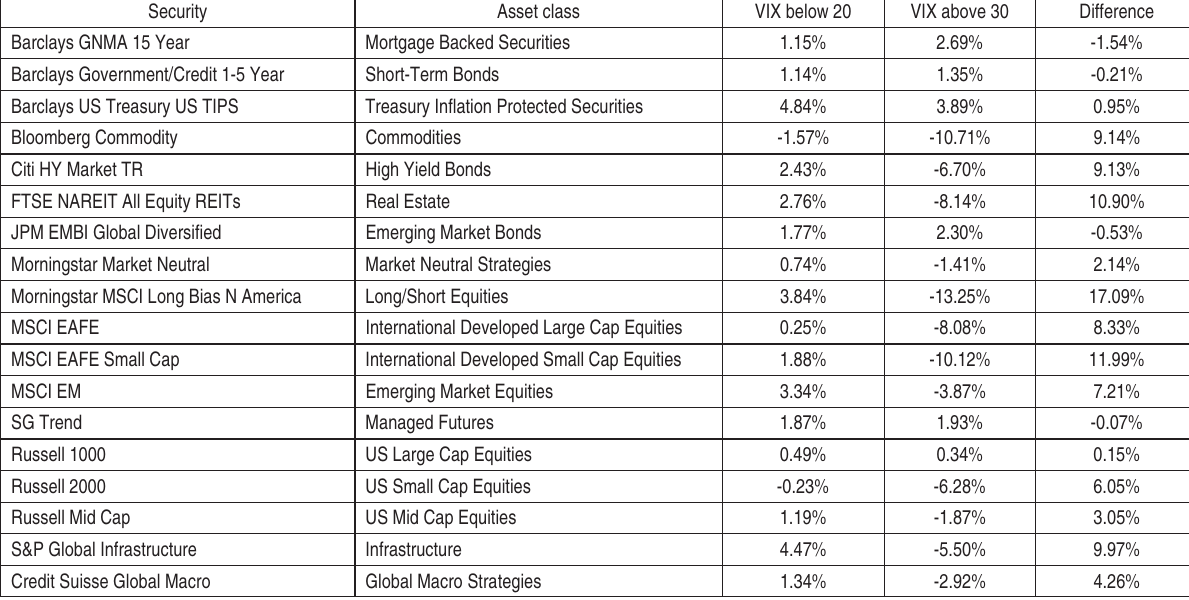
Table 1. Asset class returns vs the